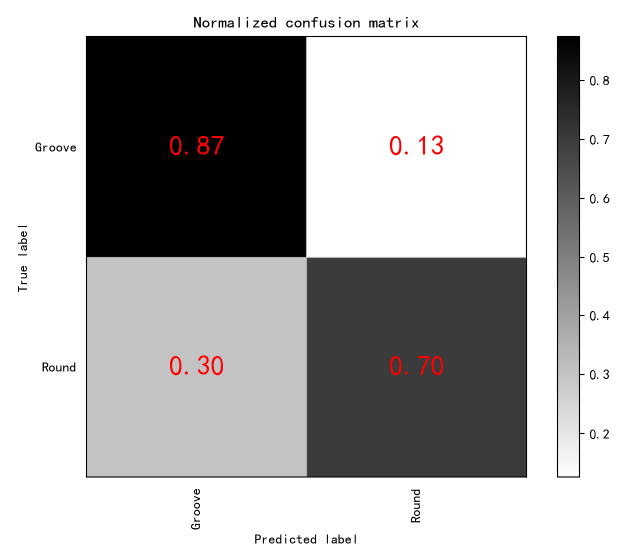
Figure 10. Decision tree for Normalized confusion matrix.